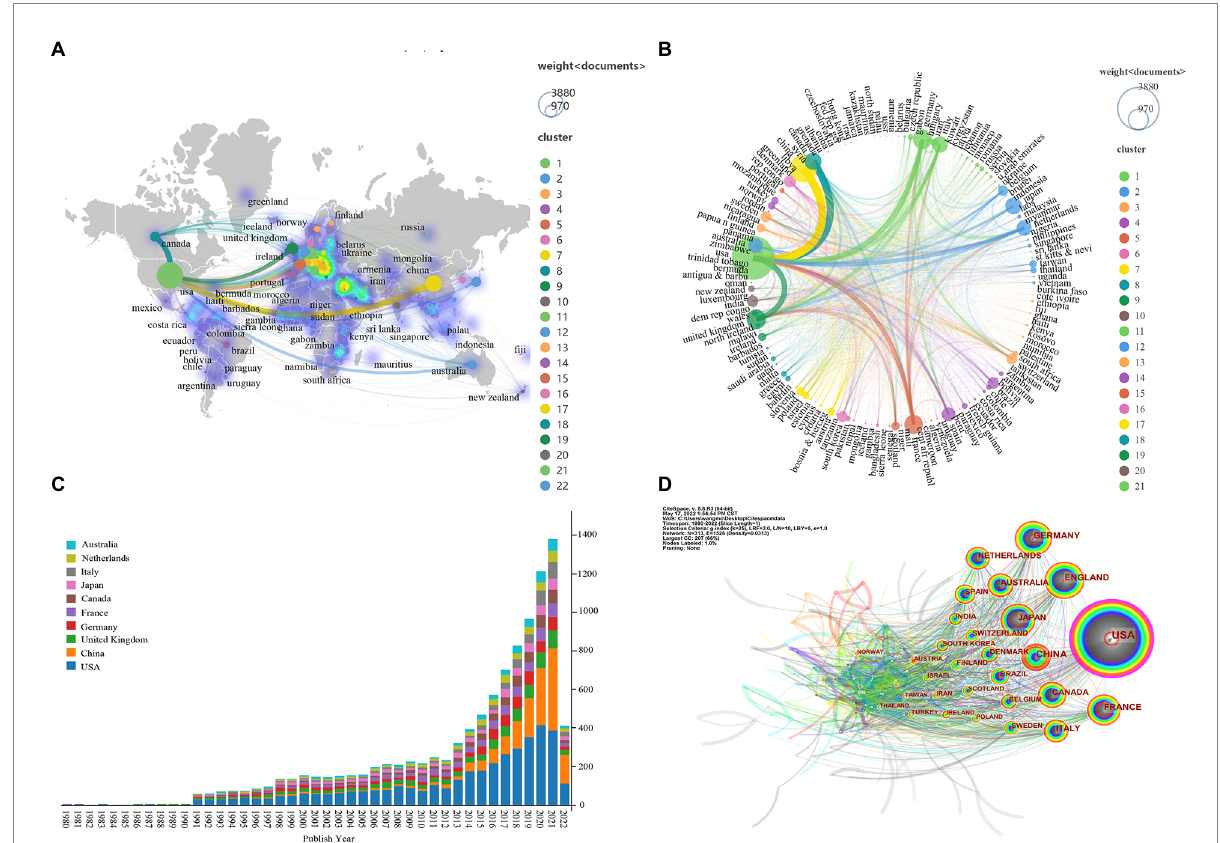
FIGURE 4 The global distribution and cooperation network of FMT research. (A) The global distribution of FMT research. The size of the circle represents the number of total publications in different countries, the width of the lines between different countries represents the strength of their cooperation. (B) The cooperation network of FMT research in different countries. The size of the circle represents the number of total publications in different countries, the width of the lines between different countries represents the strength of their cooperation. (C) The annual publications and trends of the top 10 countries. (D) The total citations of publications in different countries. The overall size of the circle represents the number of publications in different countries. Each colored circle (tree ring history) represents the number of publications published by that country in a single time slice. The width of the lines between different countries represents the strength of their cooperation; The outermost purple circle represents the country has a significant role in the FMT